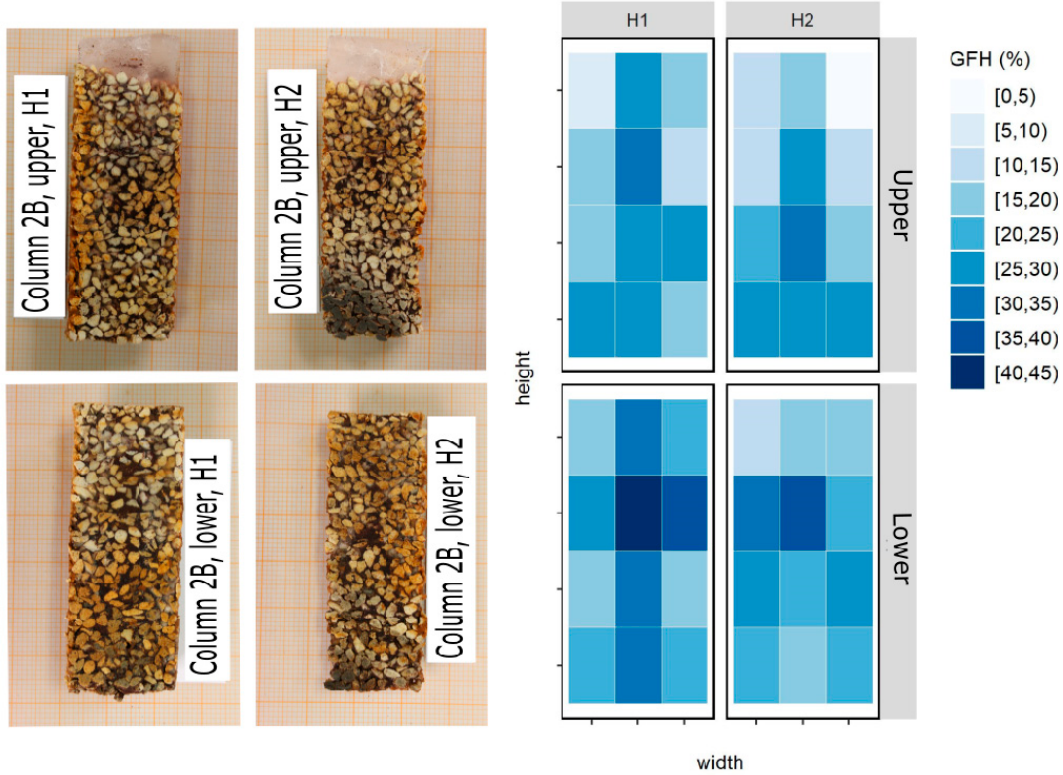
Figure 4. Vertical cross sections of the upper and lower parts of a frozen core (left) and resulting heat maps with regard to the accumulation of µ GFH particles (0–125 µ m) in the pores of